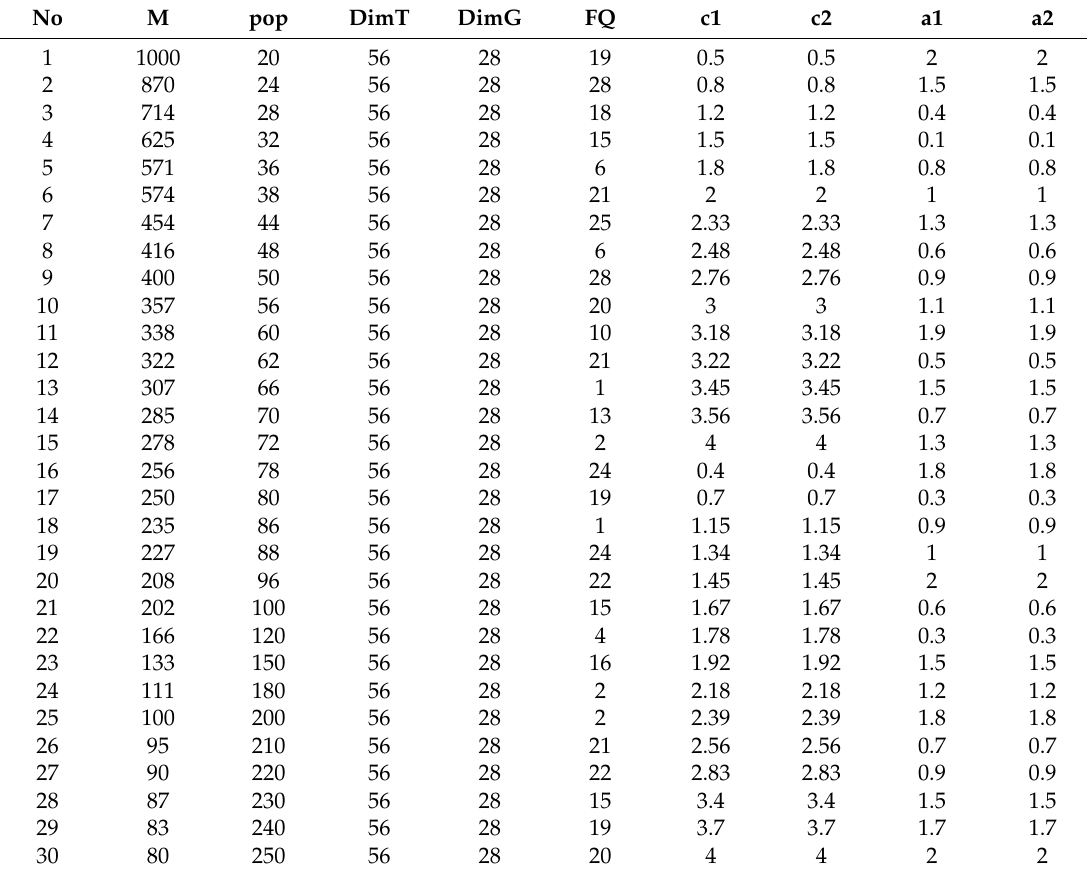
Table 2. Parameters used in BSA for each experiment.